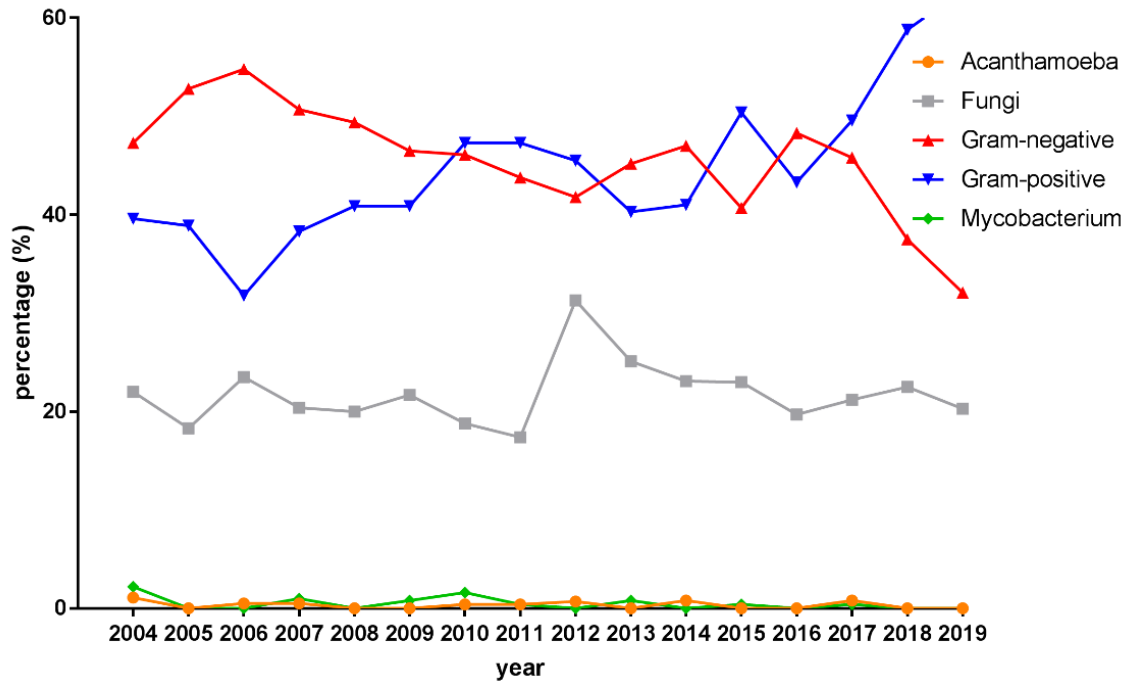
Figure 2. Percentage of microbial isolates from infectious keratitis between 2014 and 2019.